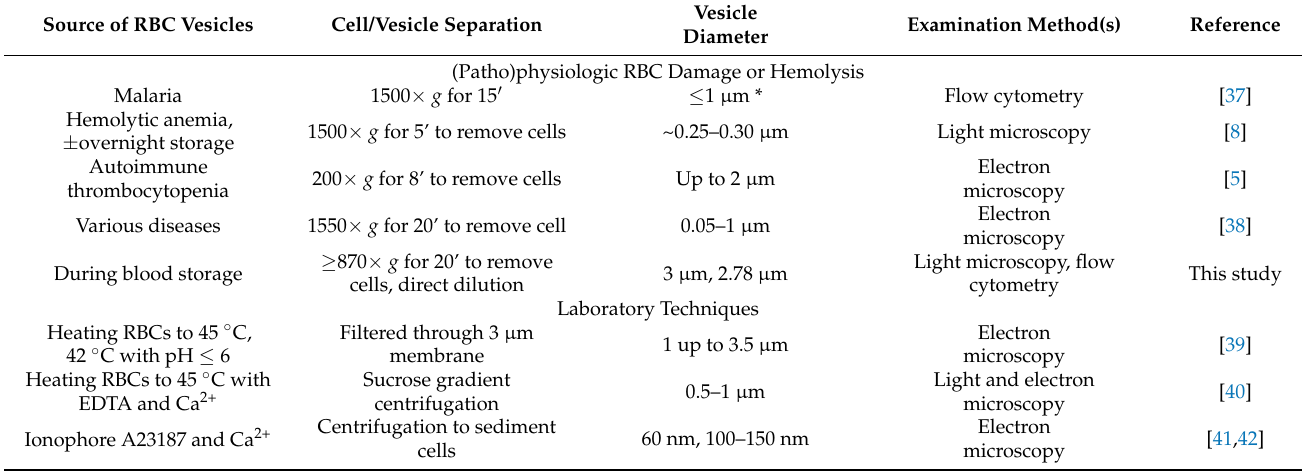
Figure 1. Gentle sedimentation revealed vesicles larger than 1 µ m in diameter. ( A ) Representative flow cytometry light scatter (forward scatter-area, or size, and side scatter-area, or internal complexity) dot plots of RBC-poor supernatant isolated by allowing newly-outdated (43–46 day old) donor blood to stand overnight at 4 ◦ C, ( B ) with 3 µ m beads added for size comparison. Staining with ( C ) anti-glycophorin-A antibodies and ( D ) lactadherin (which binds phosphatidylserine, PS) labeled ( E ) 97.5% ± 1.1% of events in 11 expired units’ RBC-poor supernatant. ( F ) Representative bright-field image of cells and vesicles in RBC-poor supernatant and ( G ) corresponding glycophorin-A fluorescent image showing relative similar fluorescence signal from the “macroparticles” of intact RBCs; arrows highlight vesicles larger than 1 µ m (“macroparticles”). Bar = 10 µ m. Table 1. Various sizes of red blood cell (RBC) vesicles including the method to isolate them from the parent cell. * Gating excluded events that were larger than 1 µ m to rule out